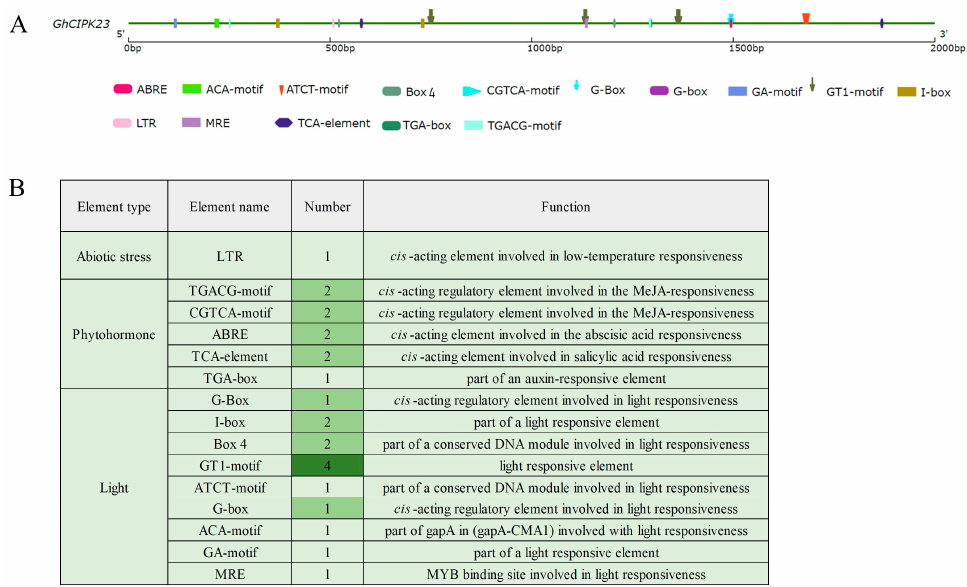
Figure 8. Cis -acting elements analysis of GhCIPK23 promoter in upland cotton. ( A ) The position distribution diagram of cis -acting elements, and different colors represent different kinds of cis -acting elements. ( B ) Category and number of cis -acting elements, and the color from light to dark represents the number of cis -acting elements from less to more.